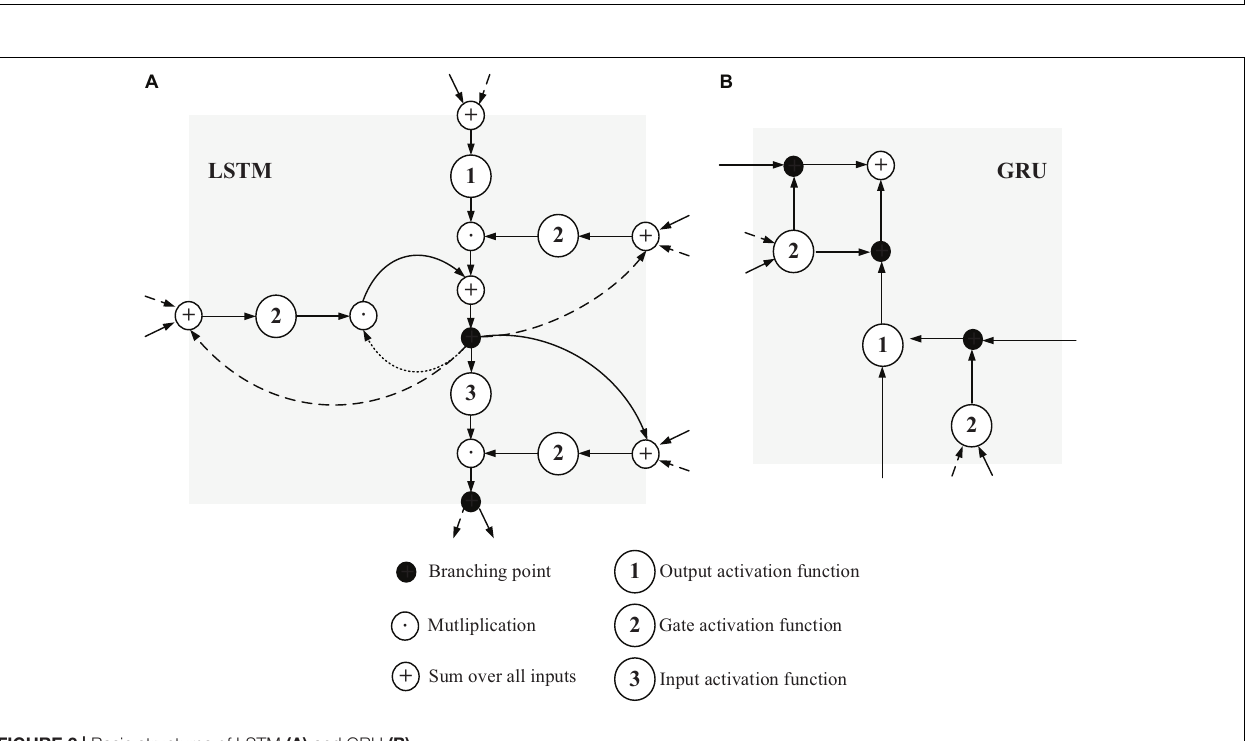
FIGURE 2 | Basic structures of LSTM (A) and GRU (B)